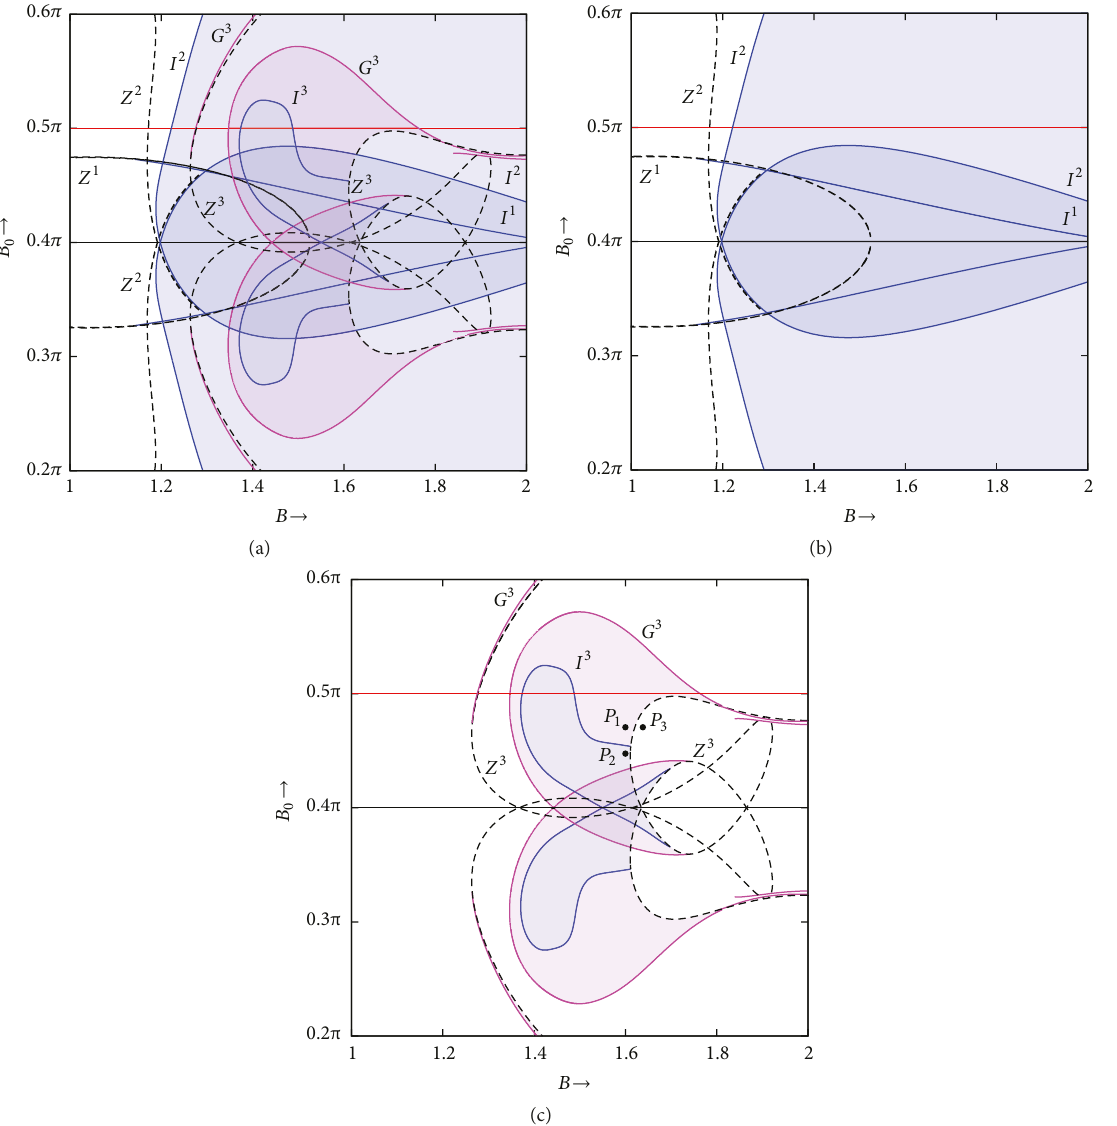
Figure 8: Enlargement of Figure 6. (a) All bifurcation sets that we calculated; (b) bifurcation sets of 1-periodic and 2-periodic orbits; (c) bifurcation sets of 3-periodic